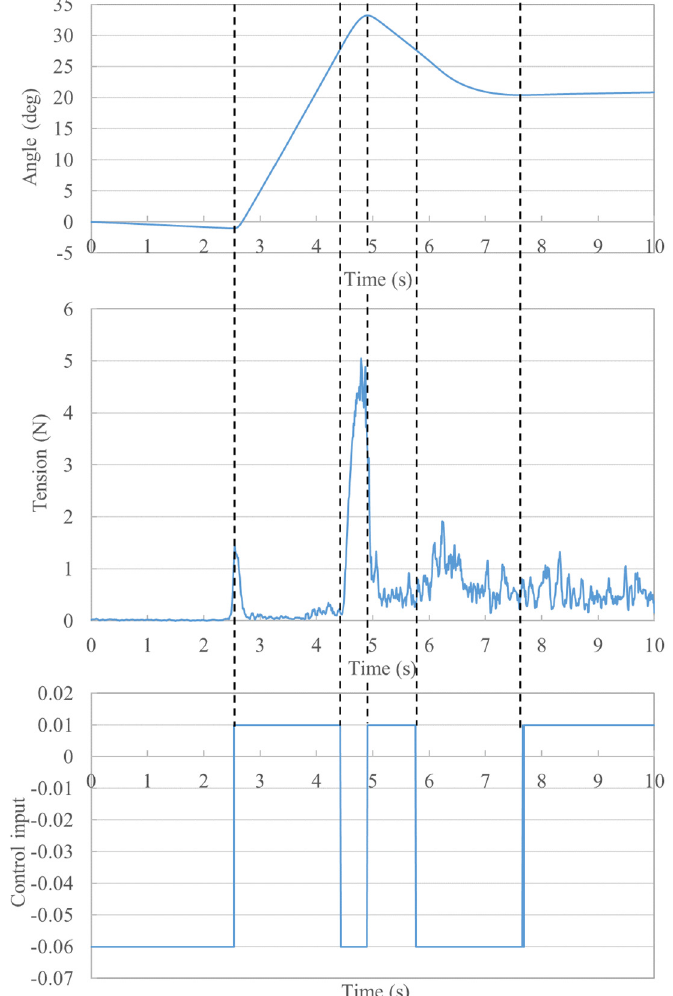
Figure 13. Time history of angle, tension, and control input for condition 1-1.